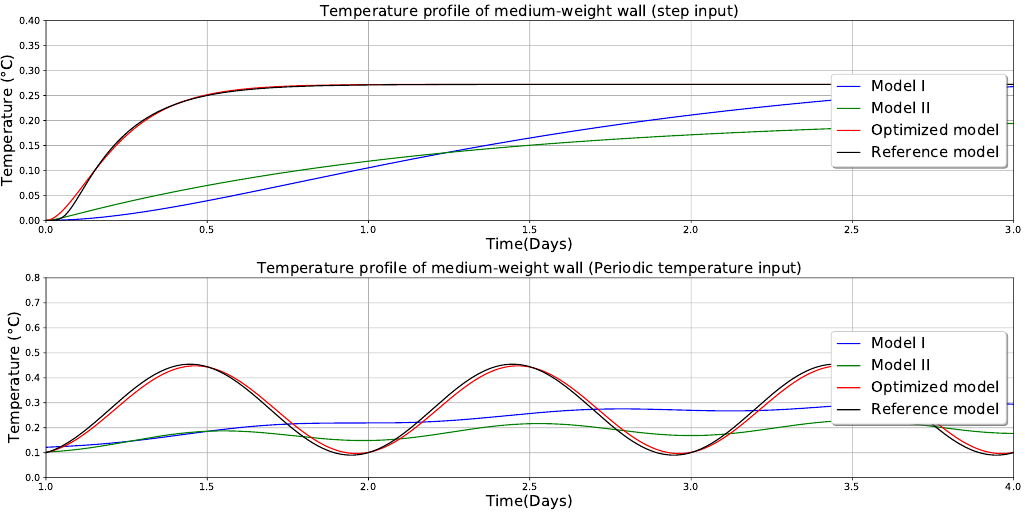
Figure 5. Temperature dynamics of reference, optimized and comparison models for medium weight